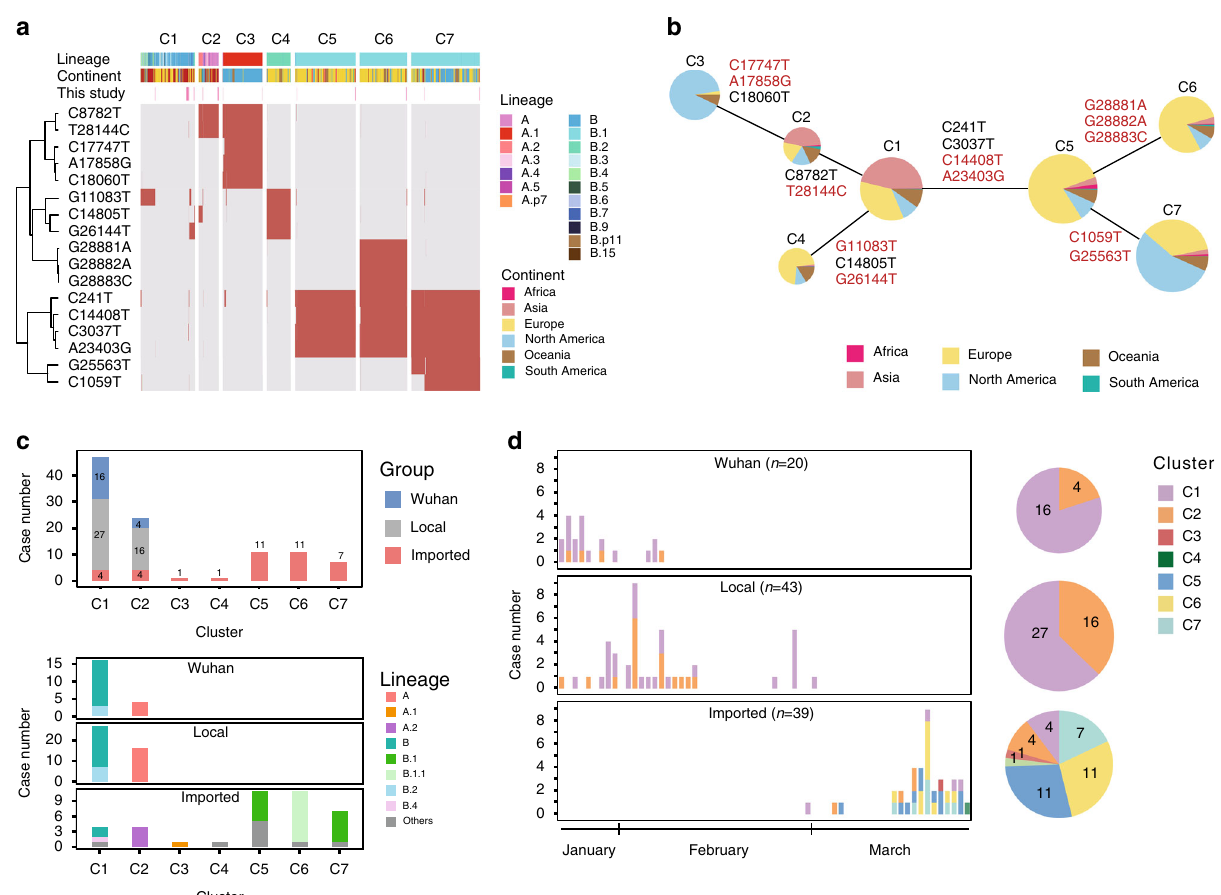
Fig. 2 Genotype analysis and lineage determination of the viral genomes and the difference among the three groups. a The viral genotypes from our data and public genome data. The heatmap shows genome clustering based on 17 high-frequency SNPs. The purple lines above the heatmap indicate the genomes sequenced in this study. The sublineages are marked on the top 16 , and the geographic sources of the genomes are marked below the lineage. b The minimum-spanning tree of the seven clusters. The genomes from different continents are displayed on the pie by colors. The SNP differences are displayed on the lines between two clusters, and those caused by non-synonymous mutations are in red. c The histogram on the top displays the numbers of genomes we sequenced from each group in each cluster, and that at the bottom displays the early major lineages 16 corresponding to each cluster. d The numbers of viruses from different clusters emerged in the three groups during the outbreak. The pie charts at the right show the proportion of the clusters in the three groups. Source data are provided as a Source Data fi